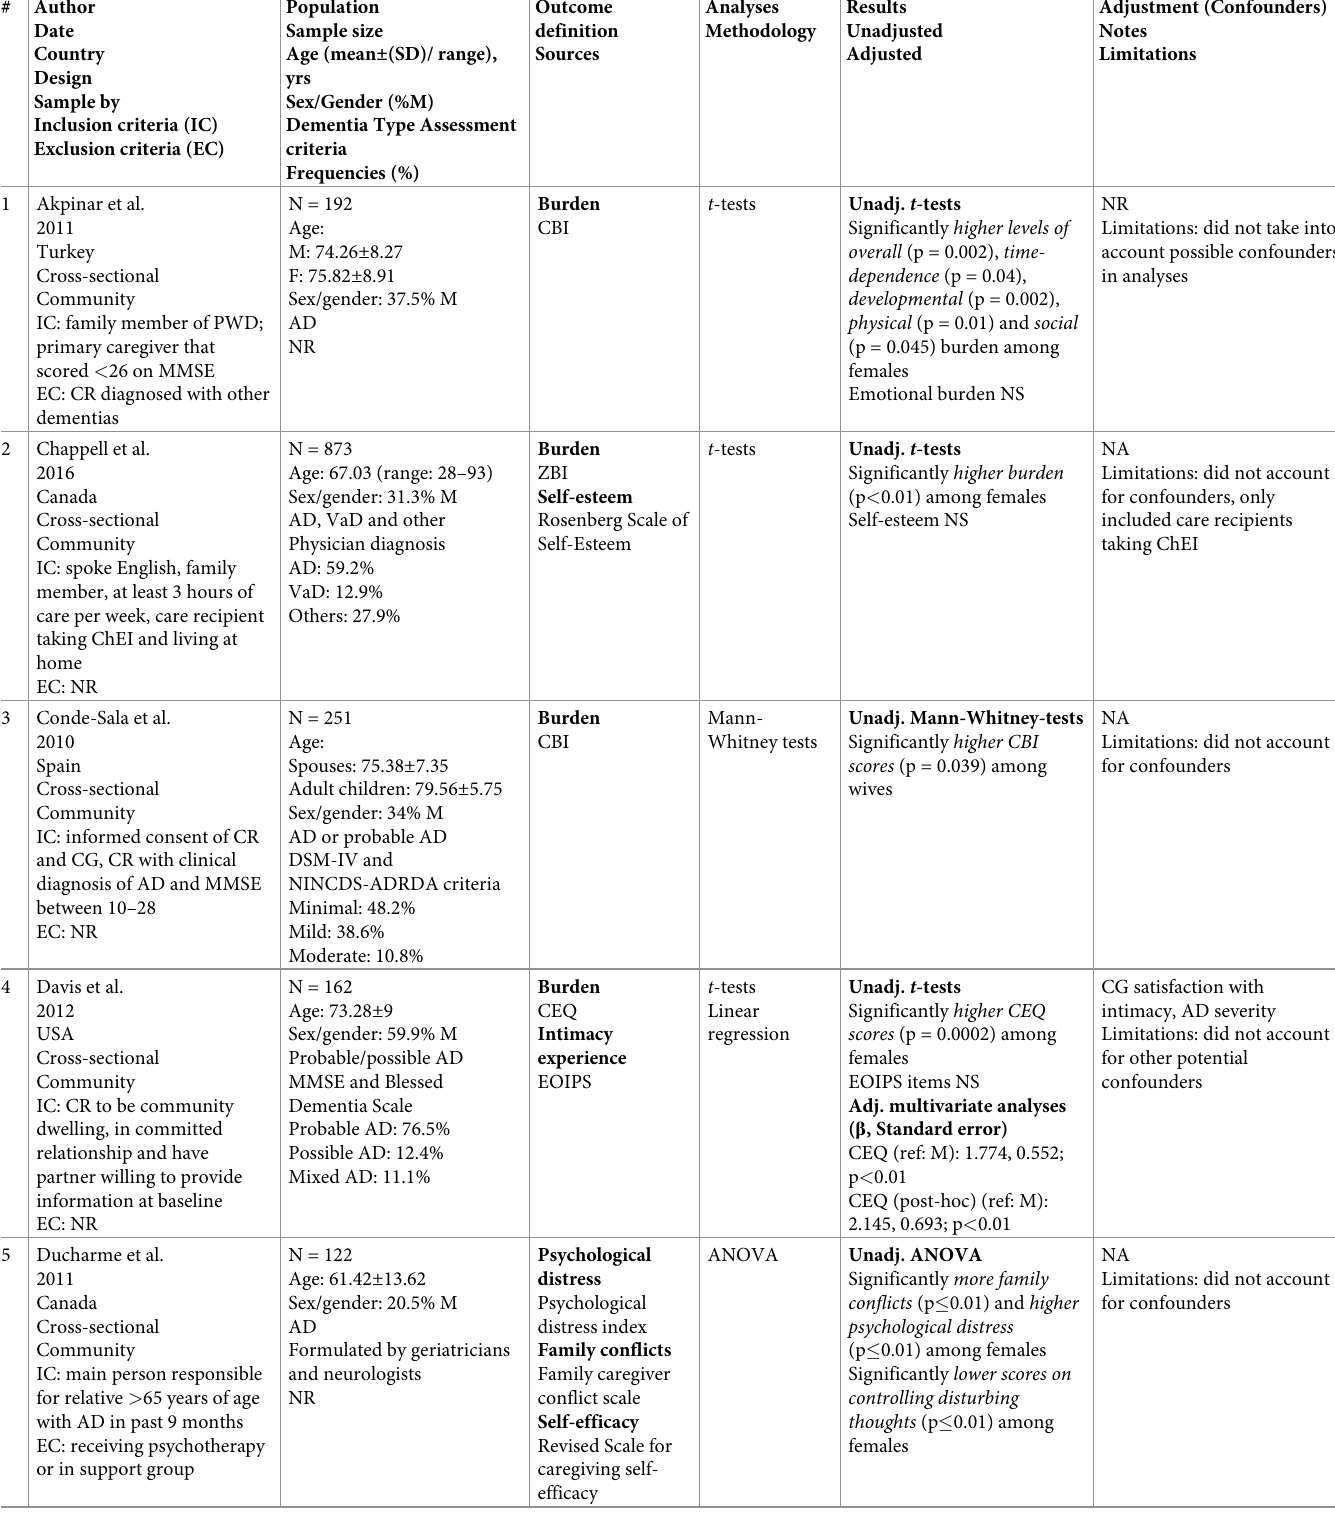
Table 1. Findings of all included quantitative